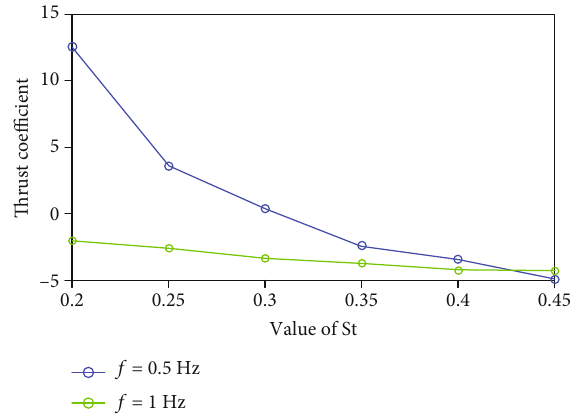
Figure 7: The mean value of the force of the caudal fi n changes with St